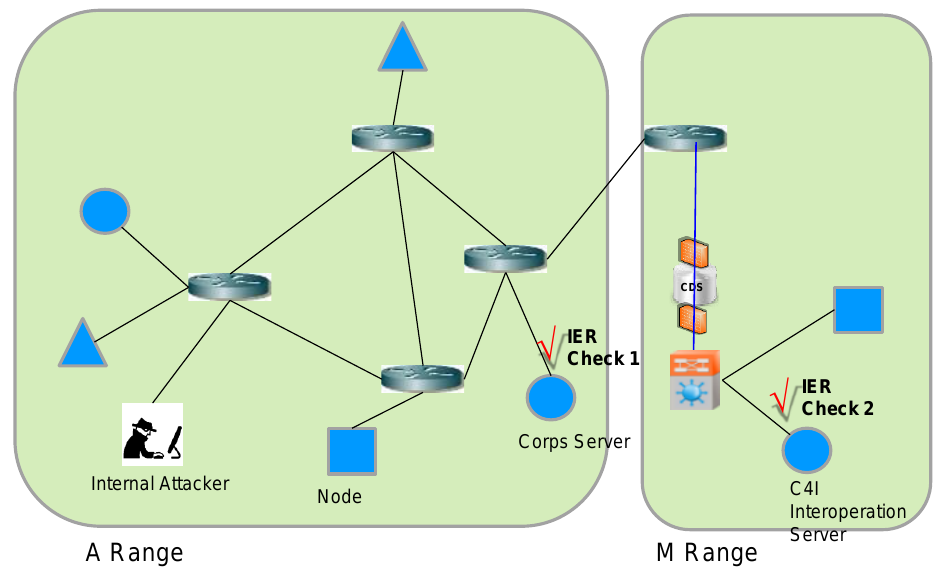
Figure 13. Test environment for IER process. Table 2. Experiment Characteristics.